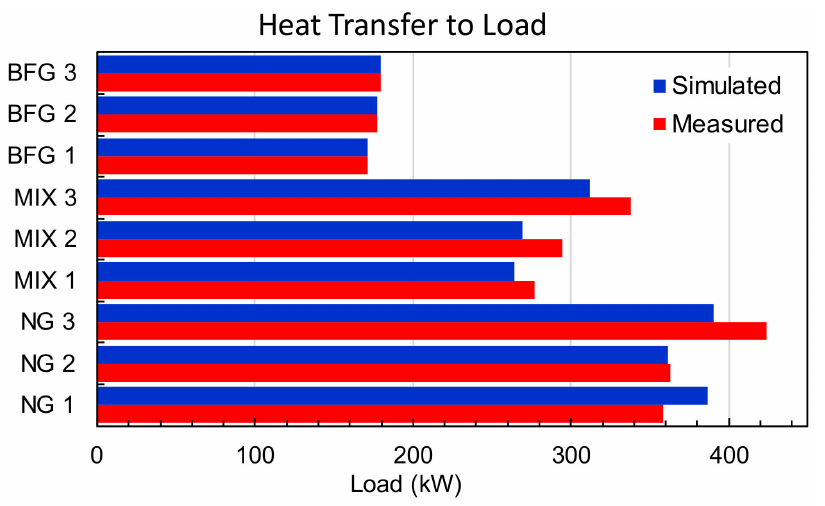
Figure 8. Comparison of transferred heat to the load measured and